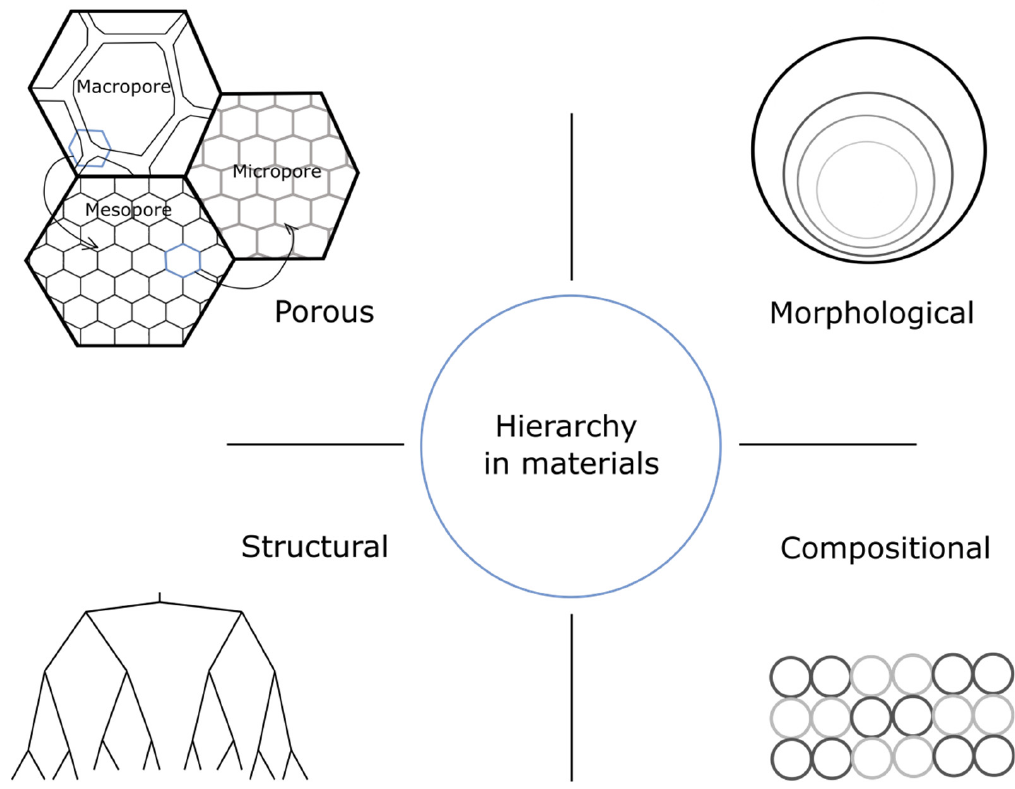
Figure 3. Types of hierarchy in